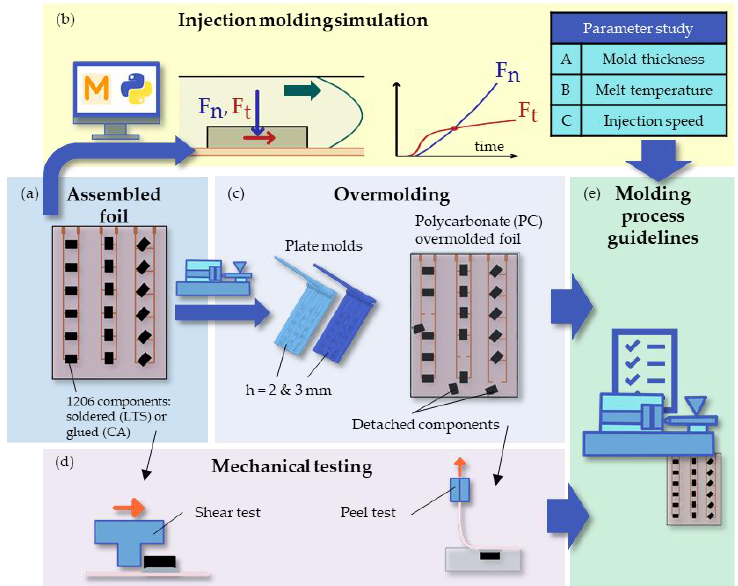
Figure 1. Workflow to study the impact of injection molding parameters on detached components: The foil design with soldered resistor components developed in [9] ( a ) was numerically simulated in parameter studies in which the normal ( F n ) and the tangential forces ( F t ) on the components during filling were investigated ( b ). Additional injection molding tests were conducted on the results in [9], and the detached components were counted after overmolding ( c ). Further mechanical tests like shear and peel tests investigating the mountings’ strength were made ( d ). Finally, the findings concerning simulation, overmolding process, and mechanical testing were combined to extract guidelines for injection molding of assembled foils ( e